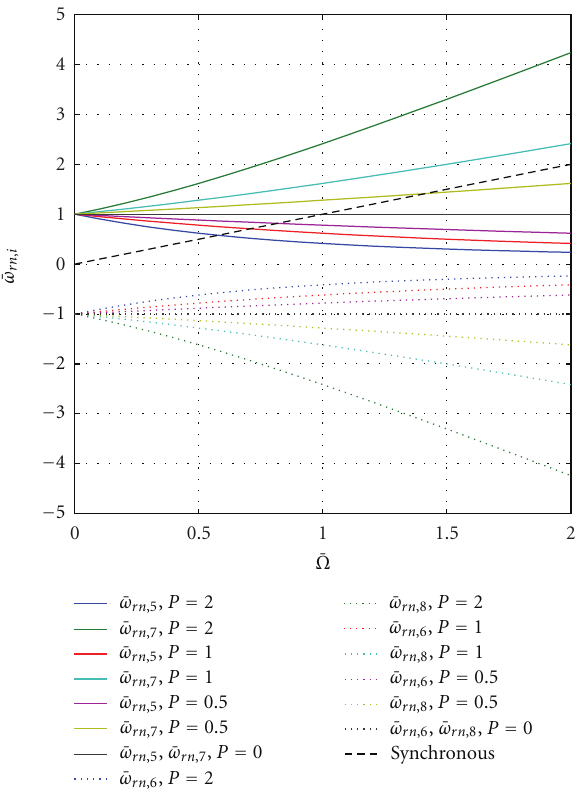
Figure 2: Rigid rotor Campbell diagram, tilt modes, ζ r ,0 = 0.